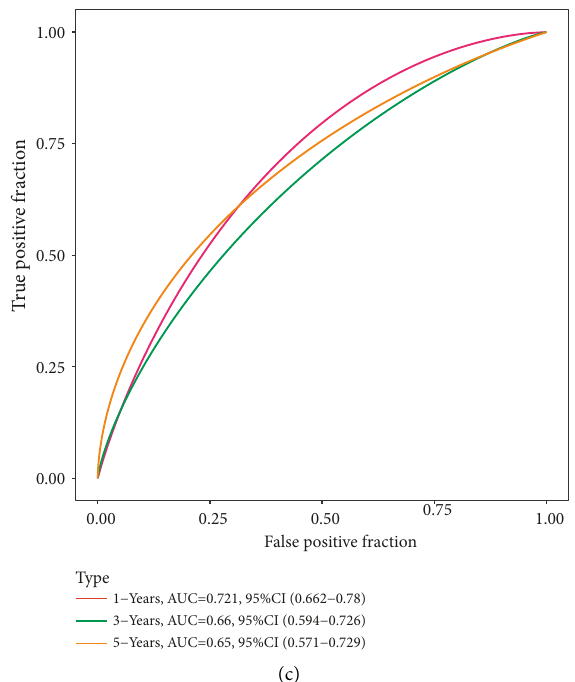
Figure 4: Risk model for MPV17 and LIHC. (a) The relationship between MPV17 expression, survival time, and survival status. (b) Overall survival probability of MPV17 expression in high-risk and low-risk groups. (c) ROC analysis on MPV17 and LIHC prognosis at 1, 3, and 5